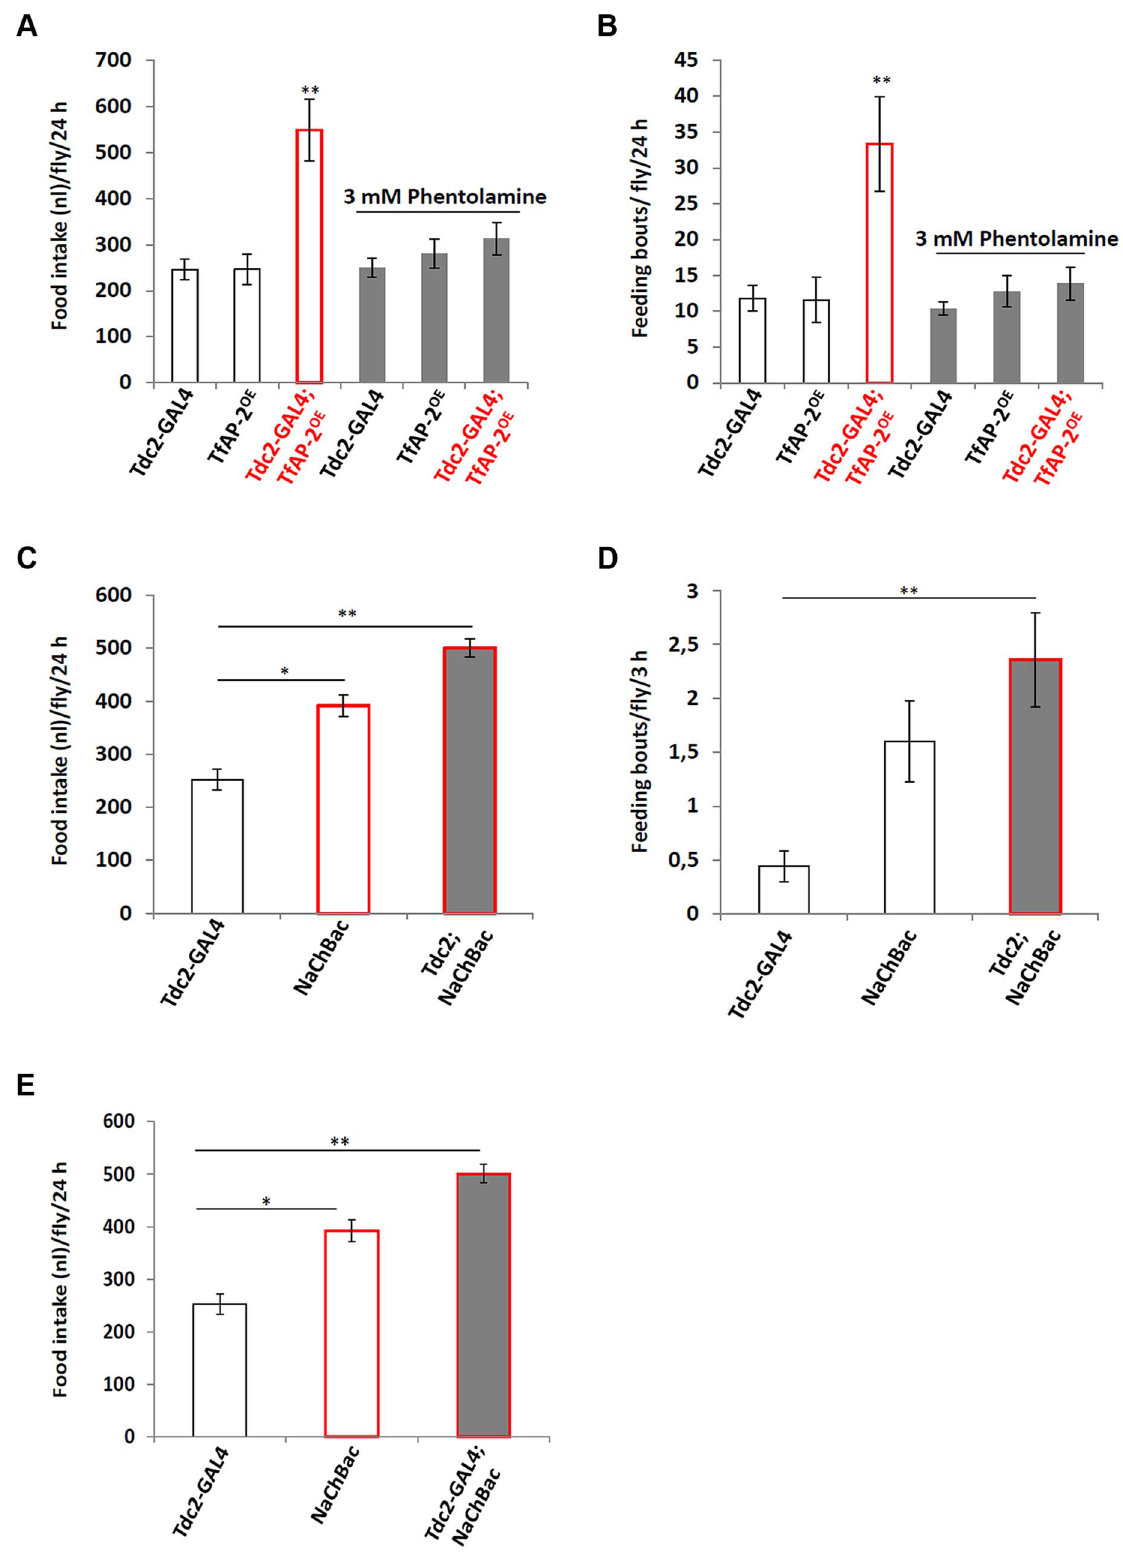
Figure 4. Octopamine regulates feeding behavior. (A,B) Male flies were fed 3 mM of the octopamine antagonist phentolamine before a CAFE assay was performed to assess total food intake (A) and the average number of feeding bouts (B) over a 24 h period in 5–7 days old adult males. Five males were used for each replicate and the assay was repeated at least 10 times for each genotype (A non-parametric Kruskal-Wallis ANOVA was performed with Dunn’s post hoc test for multiple comparisons, P , 0.005). (B,C) Overexpression of a bacterial sodium channel in octopaminergic